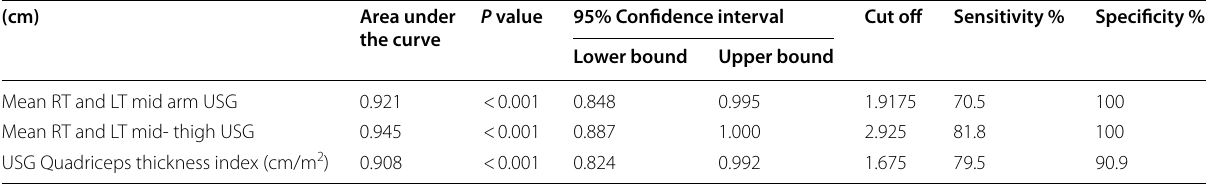
Table 8 Cut off values for male muscle layer thickness (cm)